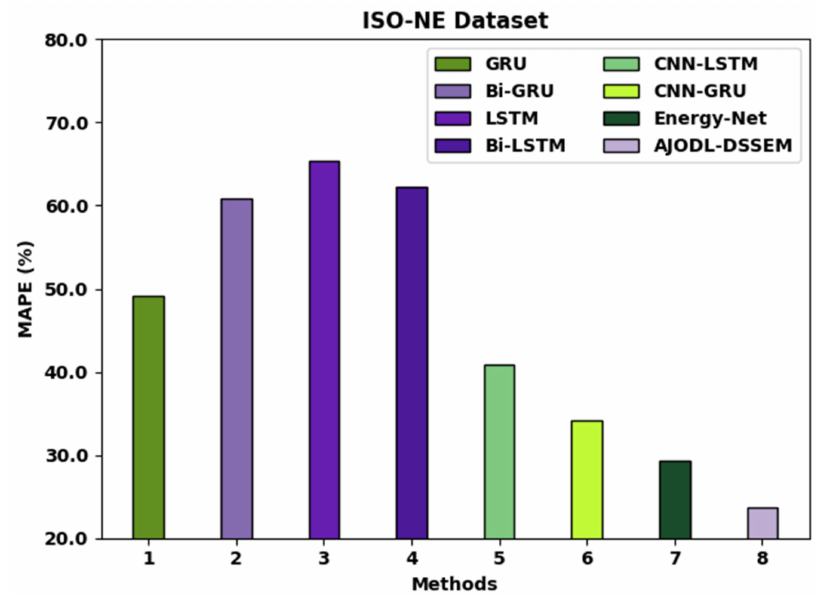
Figure 11. MAPE analysis of AJODL-DSSEM technique under ISO-NE dataset.